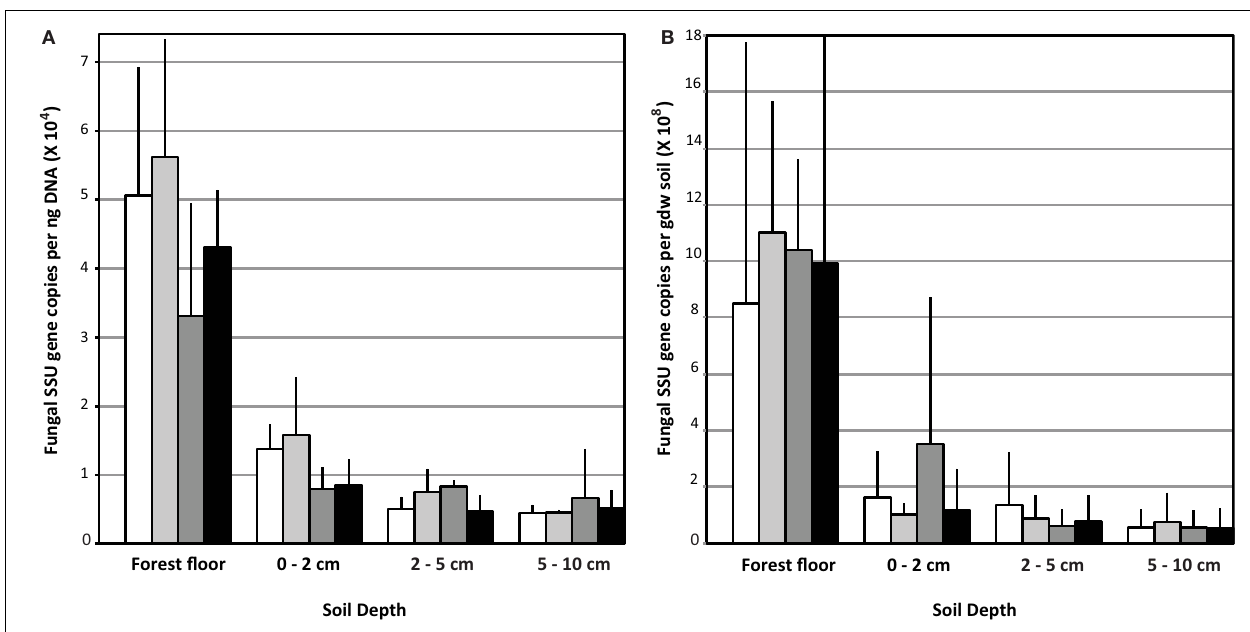
FIGURE 1 | Fungal ribosomal small subunit gene copy number: Data are represented as the mean copy number ( n = 9) with the standard deviation per ng DNA (A) and per gram dry weight (gdw) (B).